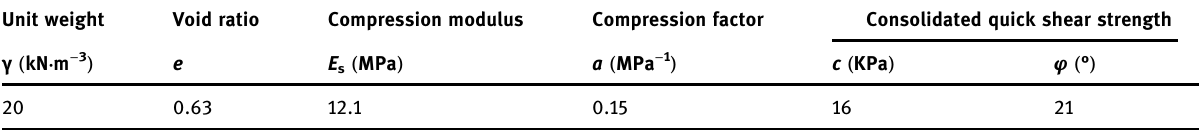
Table 2: Physical parameters of tailings